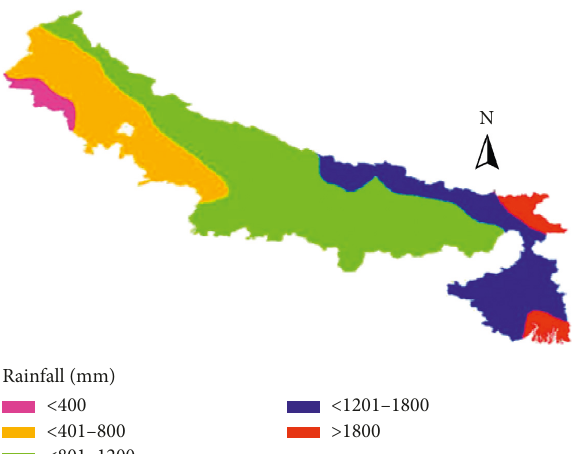
Figure 7: Precipitation over the IGP: the colours depict the level of monsoon rains (Kharif) over the Indian and Bangladeshi parts of the IGP as adopted from Koshal (2014).